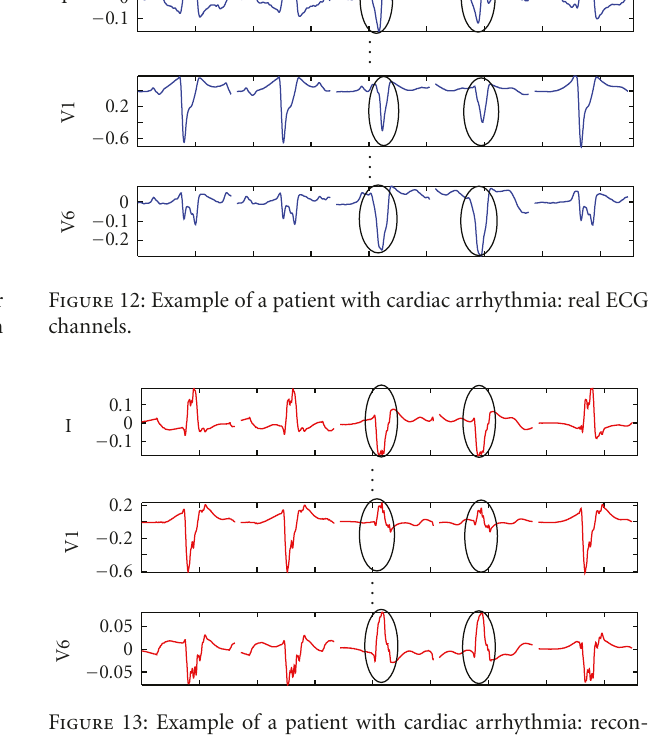
Figure 11: Example of a patient with cardiac arrhythmia: EGM channels.